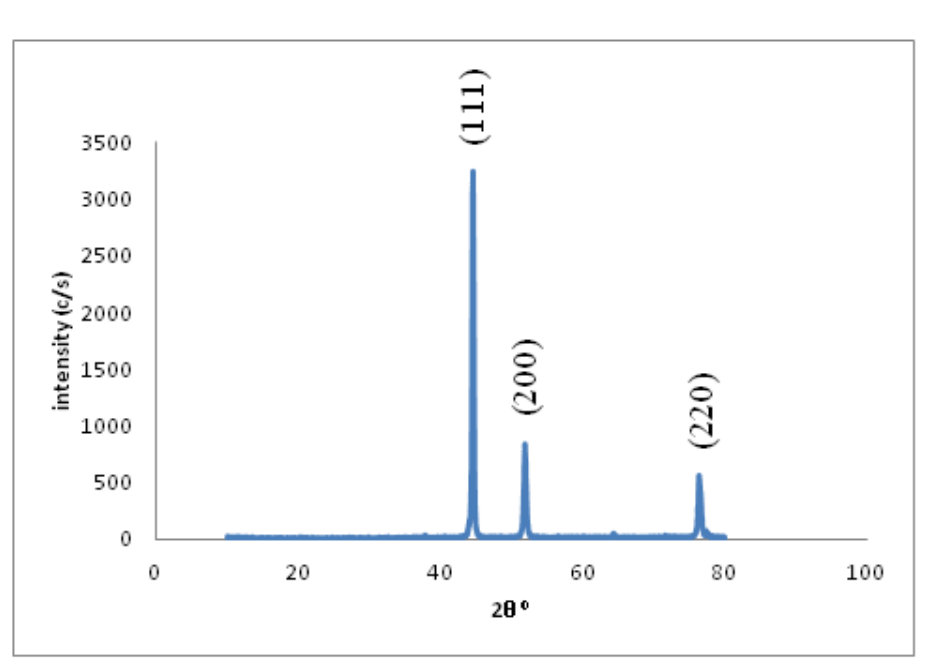
Fig.1: XRD pattern of Ni ferrite.